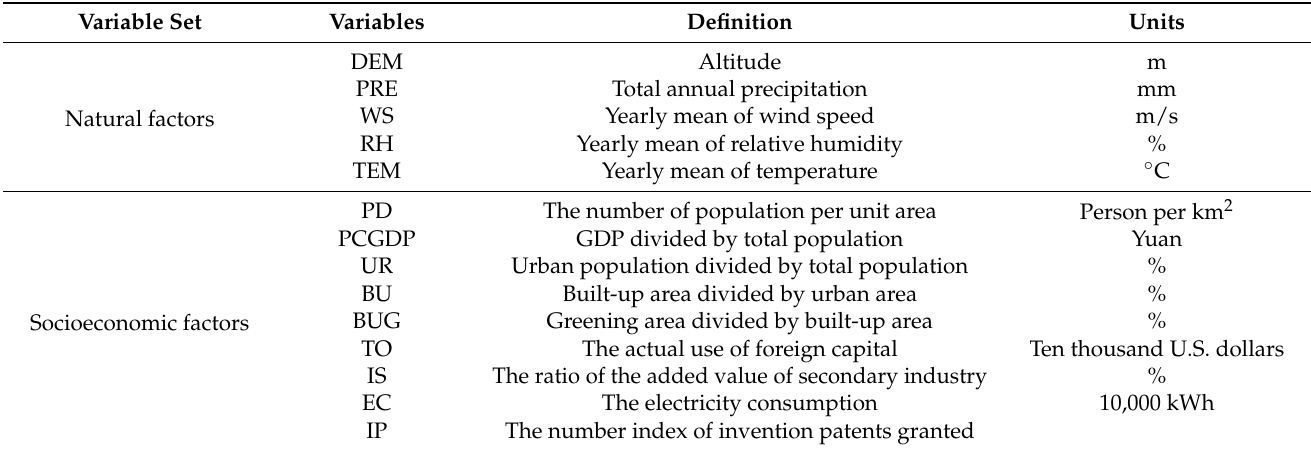
Table 1. Definitions of